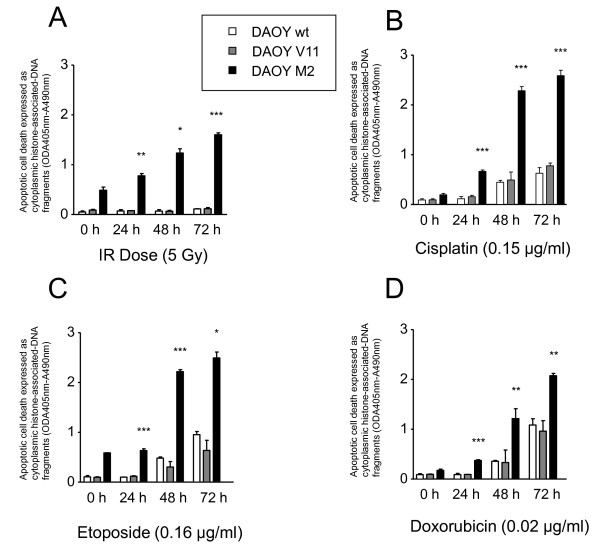
Effect of c-MYC expression on the apoptotic activity of DAOY MB cells after exposure to DNA-damaging agents. IR (A), cisplatin (B), etoposide (C), and doxorubicin (D) enhance the induction of apoptotic cell death in c-MYC over-expressing DAOY cells, as determined by Cell Death ELISA assay at the different time points indicated. Values represent the mean absorbance of cytoplasmic histone-associated-DNA fragments ± standard deviation (n = 3). Student's t-test compared DAOY M2/treated cells vs. DAOY V11/treated cells (***: P < 0.001, **: P < 0.01,*: P < 0.05).